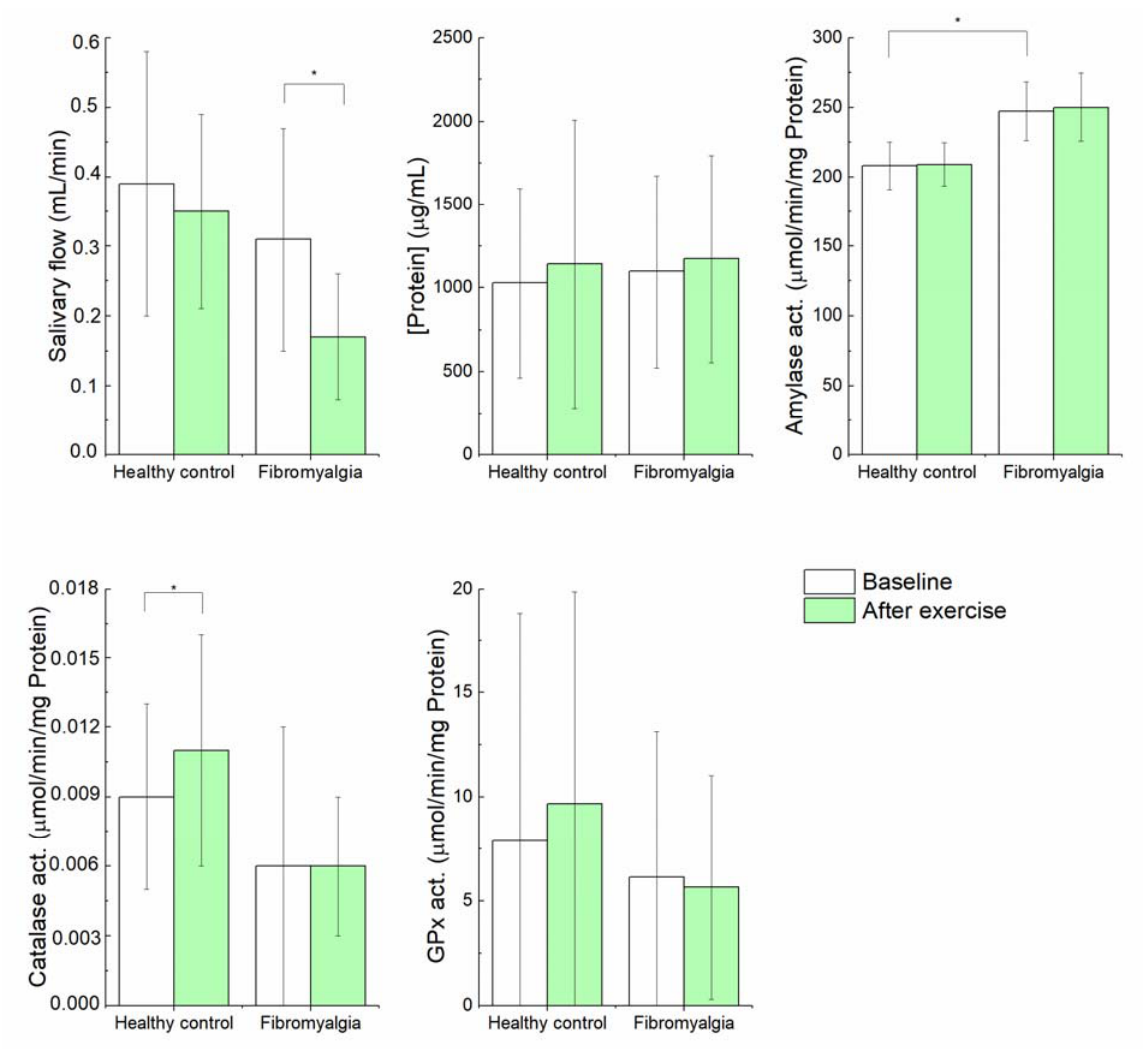
Figure 1. Differences in salivary biomarkers in fibromyalgia and heathy control groups, in baseline (white bars) and after physical exercise (green bars); * p < 0.05; (mean ± SD).